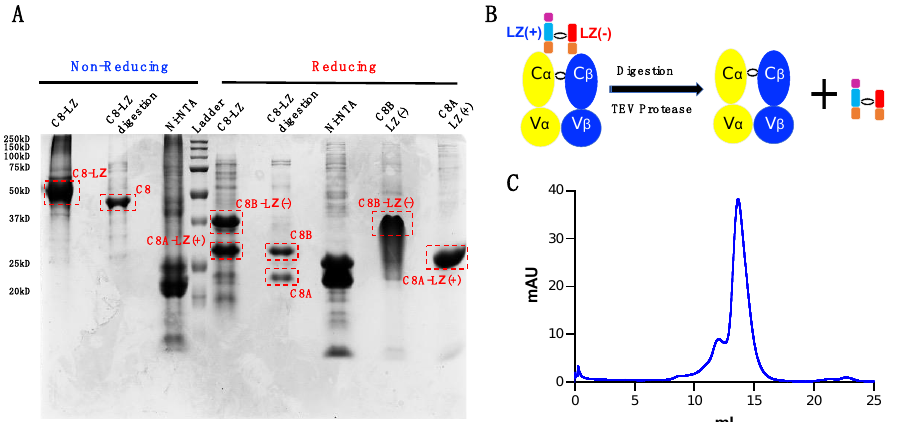
Figure 5. TEV digestion for LZ removal. ( A ) SDS-page gel examination for samples pre- and post- digestion. C8-LZ: pre-digested sample; C8-LZ digestion: digested C8 TCRαβ via reverse Ni-NTA column; Ni-NTA: post-digested proteins with a 6xHis tag bound to the reverse Ni-NTA column; C8A-LZ(+): solubilized C8A-LZ(+) inclusion body; C8B-LZ(−): solubilized C8B-LZ(−) inclusion body. ( B ) Schematic of TEV protease digestion. ( C ) s200 Superdex SEC separation of digested C8 protein.